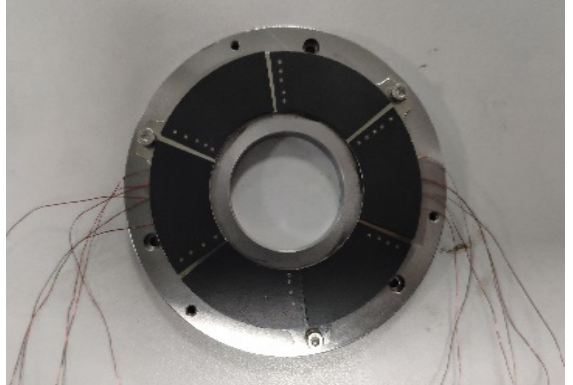
Figure 16. Physical image of experimental bearing.